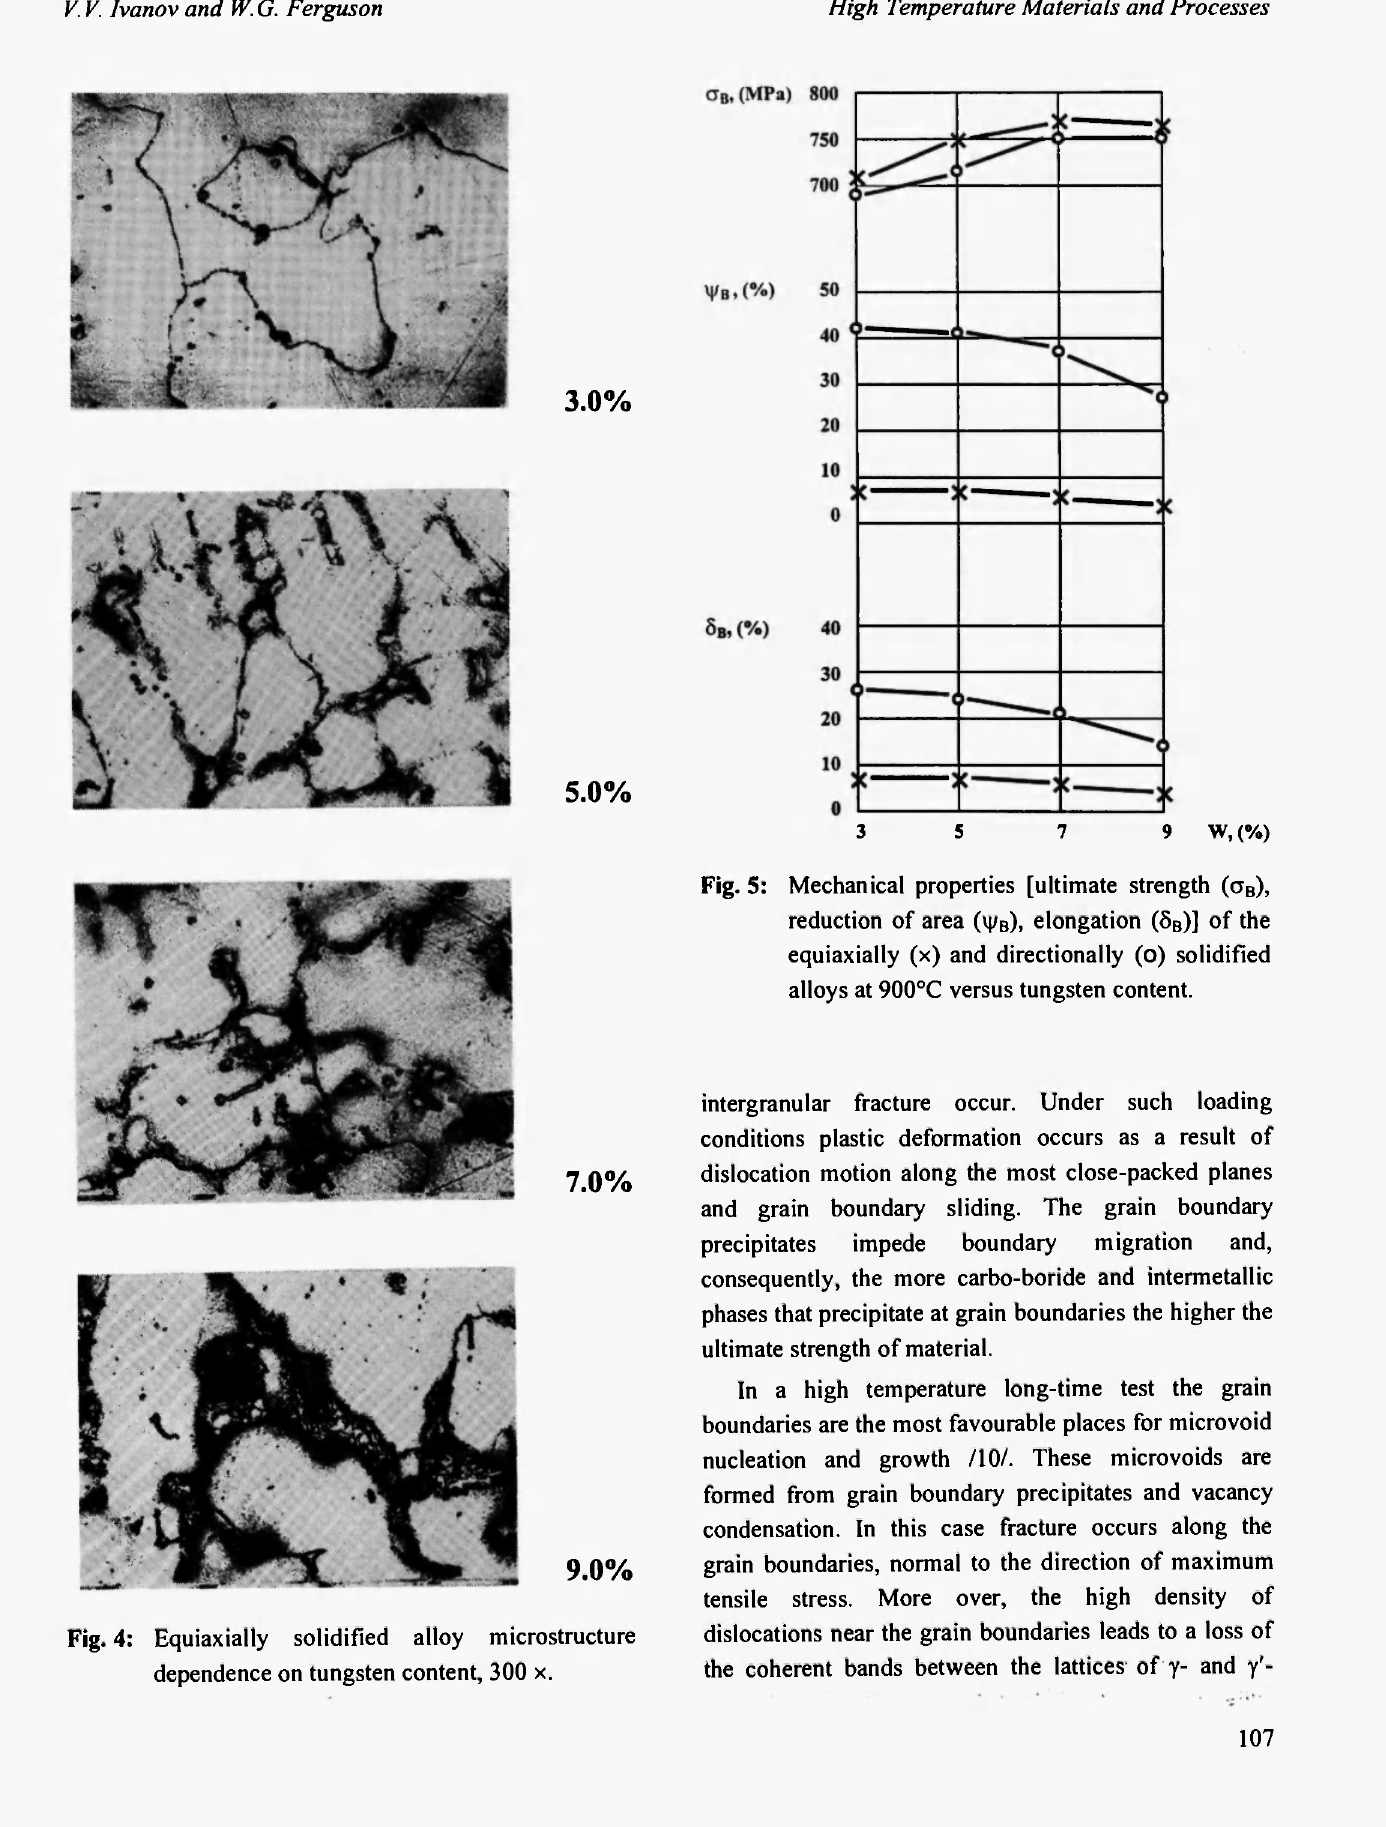
intergranular fracture occur. Under such